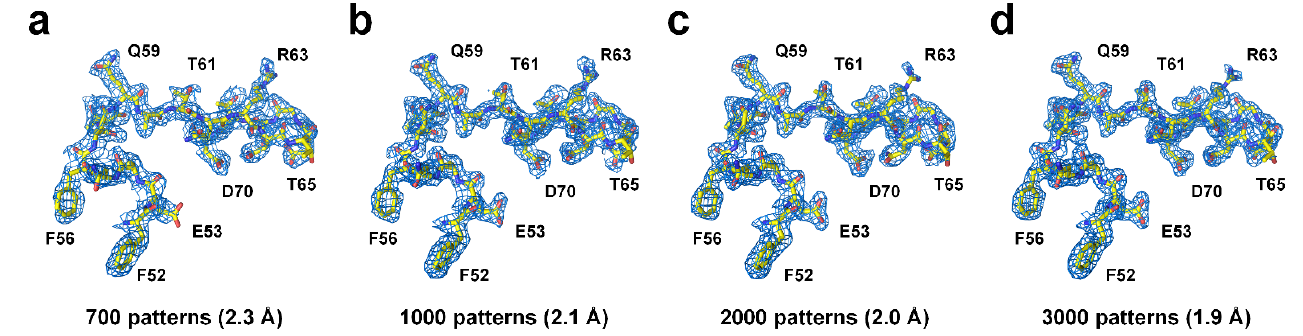
Figure 4. 2mFo-DFc (marine mesh, 1.0 σ) electron density map for the active site and substrate binding region of lysozymes merged from ( a ) 700, ( b ) 1000, ( c ) 2000, and ( d ) 3000 patterns.